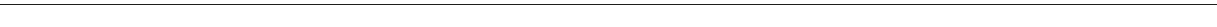
Fig. 2 Length scale of force transmission override interfacial bias and determine territory of a leader cell. a Representative landscape of average normal stress in bulk (here shown with 3D height) overlaid on corresponding phase contrast image showing groups of cells under each peak. b Actin staining image showing appearance of leader cells (shown by red arrows) at an interval d LL in phase 1. c Box plots showing no signi fi cant difference between leader to leader distance (d LL ) and the Force correlation length (F CL ) in both MDCK (top) and HaCaT (bottom) cells. d Statistical distribution of d LL two hours after the con fi nement removal (T = + 90 min) for different micro-patterned and non-patterned (unbiased) monolayers. e design of PDMS micro-stencil, demonstrating beak shape interfacial patterns to bias leader cell formation (left). Representative images of migrating LifeAct-transfected MDCK cells right after (T = 0 h, middle) and two hours after (T = 2 h, Right) the con fi nement removal, for different micropatterns. Whiskers in box plots are maximum and minimum data points. Scatter dot plots display mean with maximum and minimum range as error bars. NS: not signi fi cant, P > 0.05, Student ’ s t -test. Scale bars, 100 μ m. Data collected from at least three independent